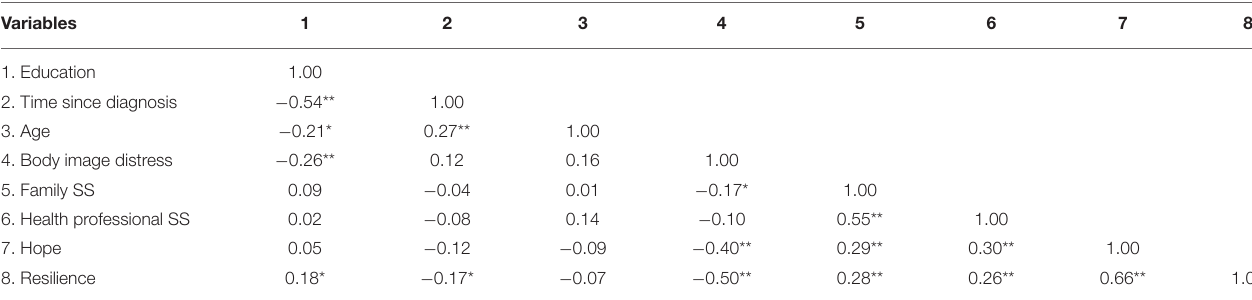
TABLE 2 | Spearman’s/Pearson’s correlations between the study